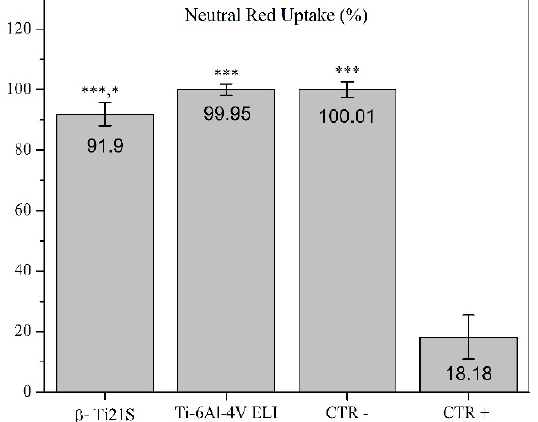
Figure 10. Lactate deydrogenase (LDH) released by the β -Ti21S (test), Ti–6Al–4V ELI (reference), and CTR − (cells without material) and CTR + (cells with a cytotoxic substance) controls. Kruskal–Wallis followed by the Mann–Whitney U test: ***: β -Ti21S, Ti–6Al–4V ELI and CTR − vs. CTR + , p < 0.0005; **: β -Ti21S vs. Ti–6Al–4V ELI and CTR − , p < 0.005.